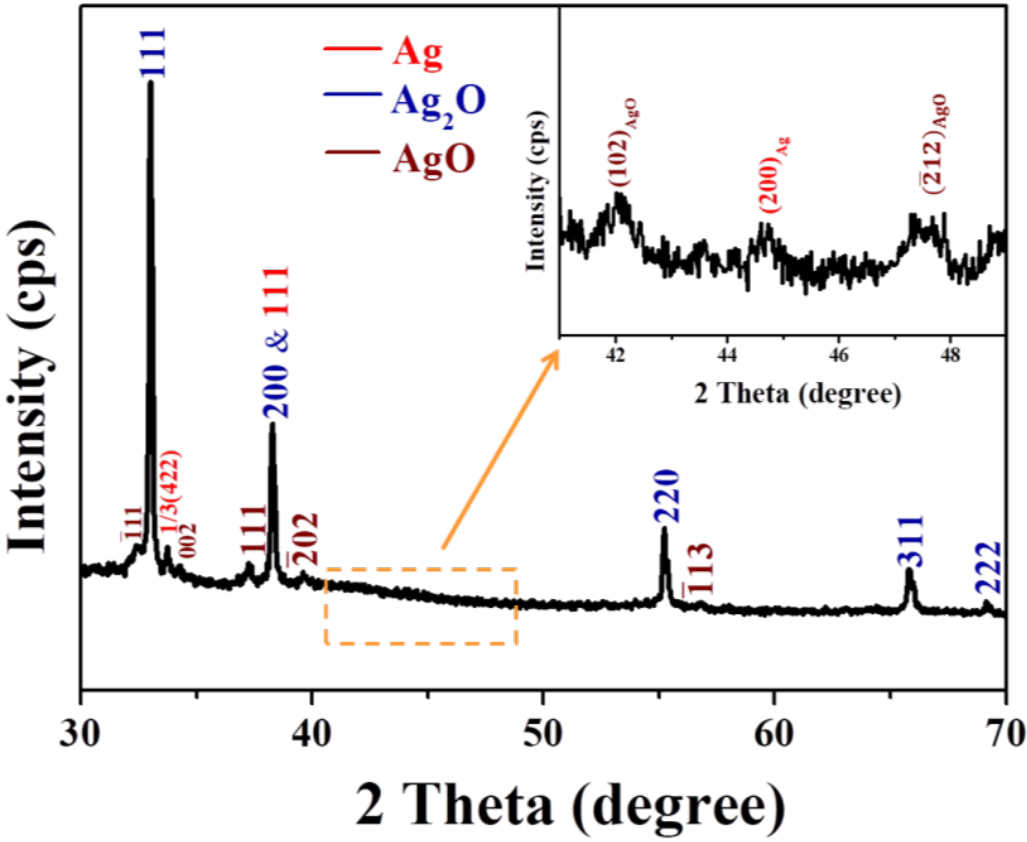
Figure 1. XRD pattern of the HSANs obtained at 60 min UV irradiation time. Concentration of AgNO 3 precursor: 5 M.